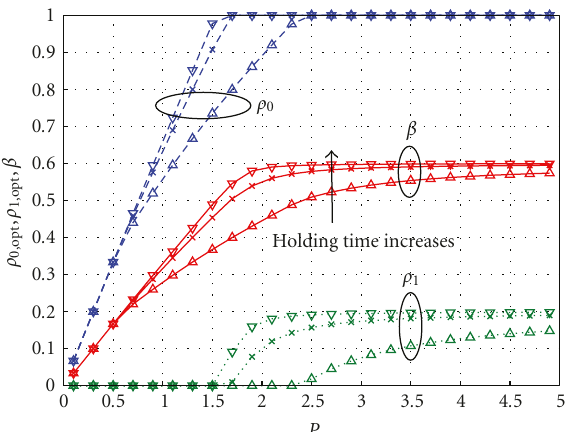
Figure 10: The optimal ρ 0 , ρ 1 , β under policy π 2 for di ff erent holding